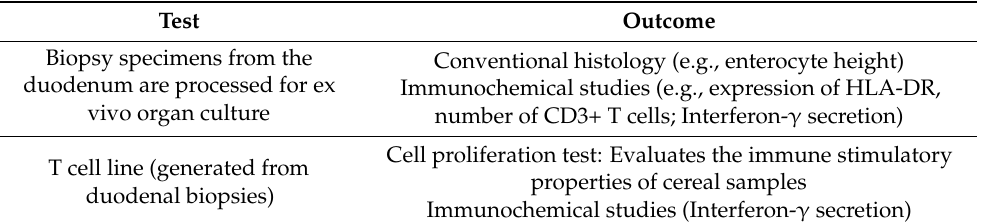
Table 2. In vitro and ex vivo tests most frequently used to evaluate the toxicity of cereals in CD. Test Outcome Biopsy specimens from the Conventional histology (e.g., enterocyte height) duodenum are processed for ex Immunochemical studies (e.g., expression of HLA-DR, vivo organ culture number of CD3+ T cells; Interferon- γ secretion) Cell proliferation test: Evaluates the immune stimulatory T cell line (generated from properties of cereal samples duodenal biopsies) Immunochemical studies (Interferon- γ secretion)